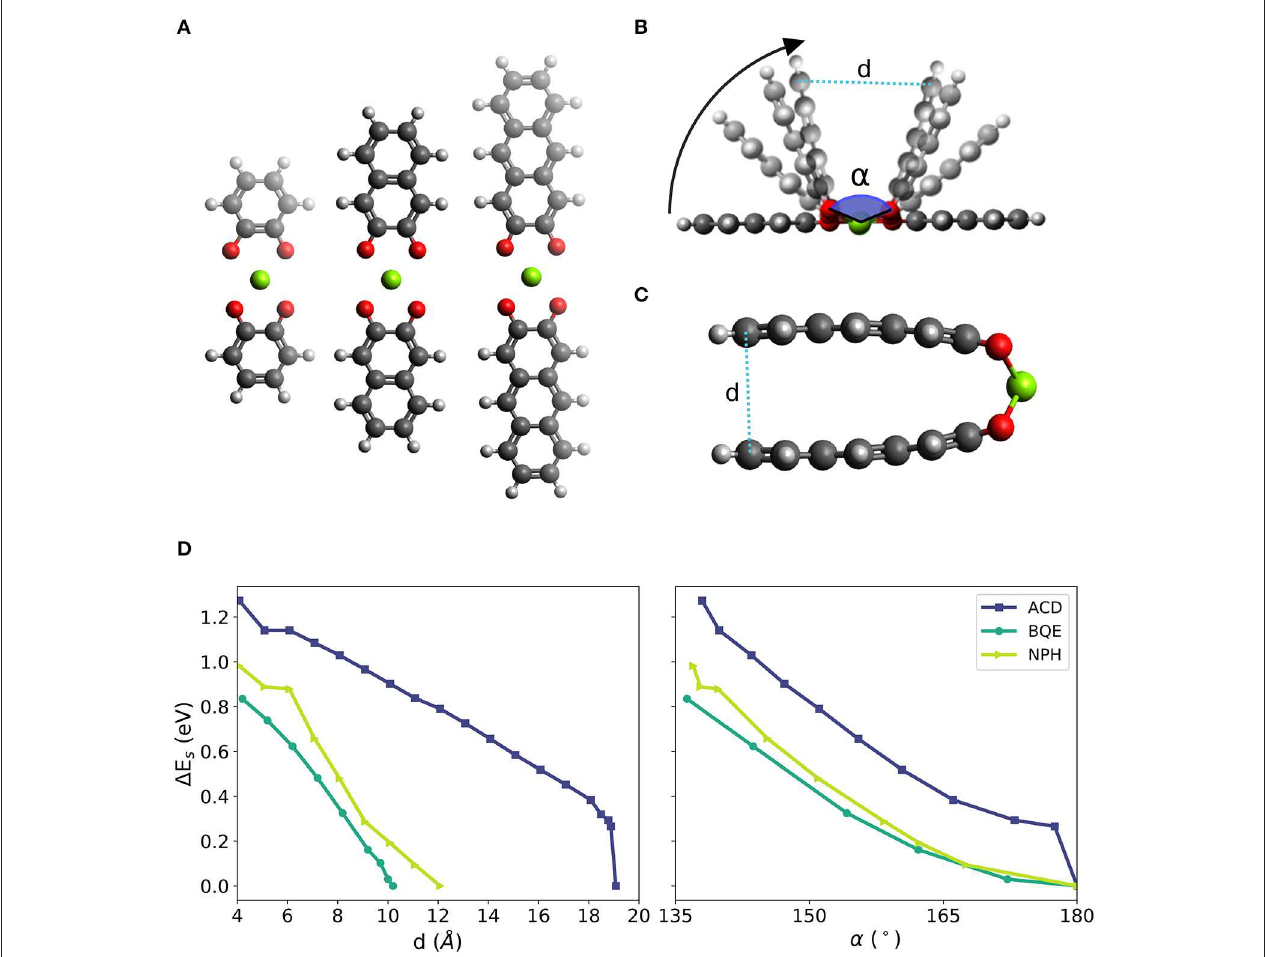
FIGURE 3 | (A) Linear configurations of two prototypical molecules of different size (from left to right: one, two and three fused benzene-like rings, i.e., complexes based 1,2-benzoquinone (BQE), 2,3-naphthalenedione (NPH) and 2,3-anthracenedione (ACD), respectively) with two neighbored carbonyl groups of each molecule surrounding one Mg atom. (B) Schematic of the bending simulations with bending angle α defined by the O-Mg-O bonds across the two organic molecules in the structure and distance d between the outer parts of the complex. (C) Example of final bending configuration of the NPH complex with almost parallel molecular planes of the two ACD molecules in the complex. (D) Change of strain energy during bending as function of distance d (left) and as function of the bending angle α